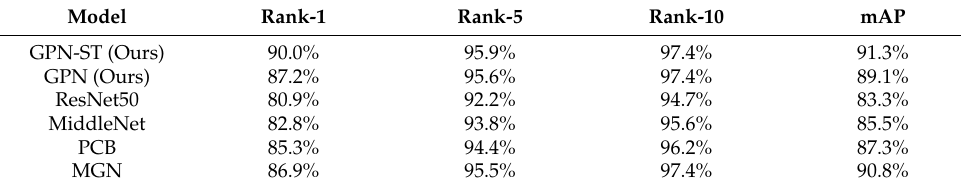
Table 1. Recognition results of different models in Gallery 1.